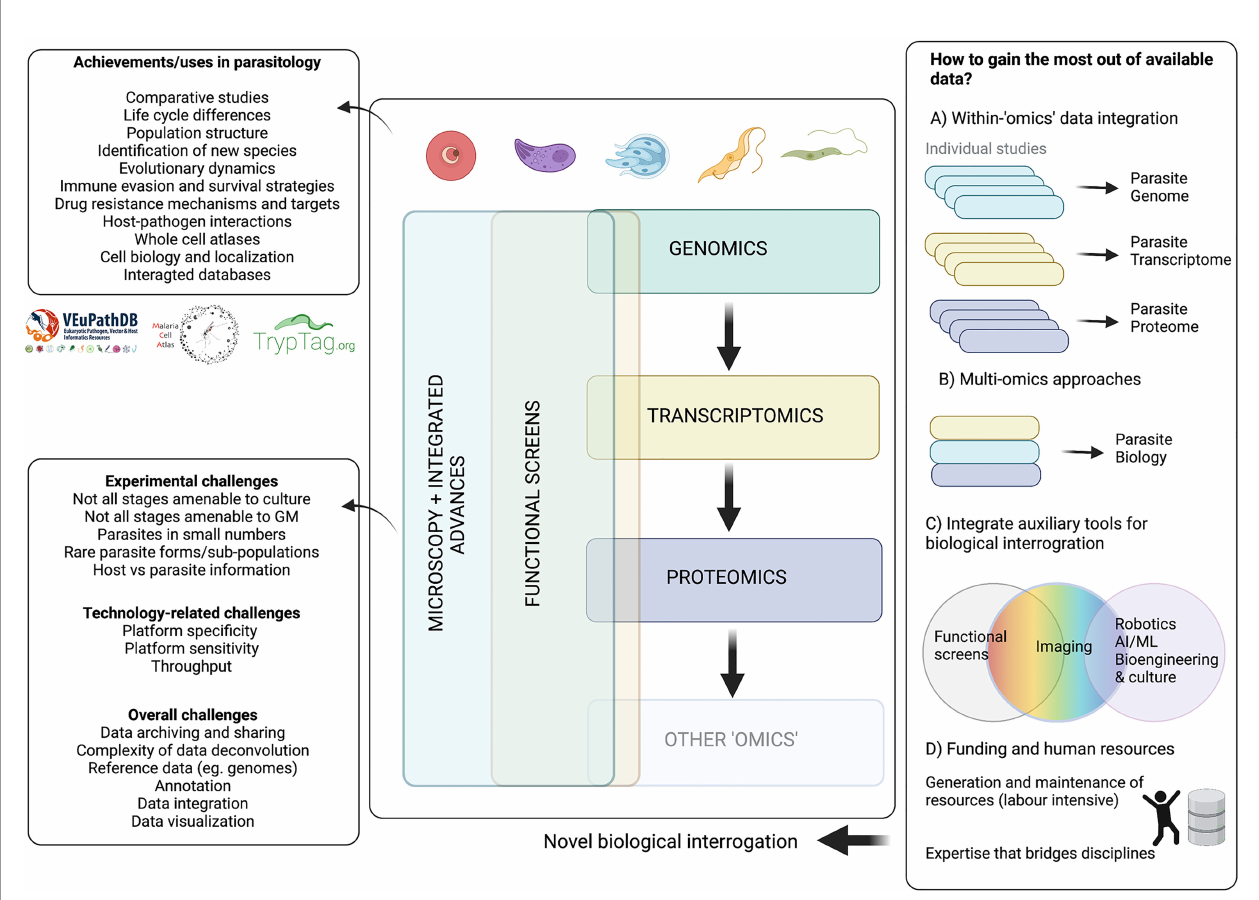
FIGURE 11 | ‘ Omics ’ technologies in parasitology: challenges and future directions. Genomics, transcriptomics and proteomics (as well as other ‘ omics ’ technologies), have allowed us to study a plethora of questions in parasitology. While bulk-based ‘ omics ’ have contributed greatly to parasitology, single cell-based ‘ omics ’ approaches have highlighted unexpected heterogeneity in parasite populations. Given the complex life cycles of Apicomplexan and Kinetoplastid parasite species, understanding the interconnection between parasite and host is key. ‘ Omics ’ technologies that allow the simultaneous investigation of parasite and host will continue to play important roles in understanding host-pathogen interactions, including topics of current major interest such as tissue tropism; immune evasion; parasite latency, dormancy, and persistence; and parasite-host circadian rhythms, among others. Functional screens based on genome mutagenesis, RNA regulation and protein regulation, have become vital tools for investigating parasite biology. Together with auxiliary technologies, such as high-throughput imaging, functional screens are powerful tools for parasitology. Current advances in microscopy are allowing valuable low-throughput techniques (eg. super-resolution, and electron microscopy), to be adapted for higher throughput. Together with the incorporation of robotics and arti fi cial intelligence, these valuable tools could become suitable for integration into ‘ omics ’ research and functional screens. Several challenges remain for ‘ omics ’ in parasitology, including experimental, technological, and overall challenges. Among the latter are the need for better data annotation and integration. We envisage that vital for an improved/increased use of available and future ‘ omics ’ data are within-omics data integration, multi-omics data integration, and multi-disciplinary data integration. Equally funding and dedicated personnel to the creation, maintenance, annotation, curation and update of available data is vital. A successful transition in this respect will enable improved collaborative science, and addressing novel and outstanding biological questions. Figure created with